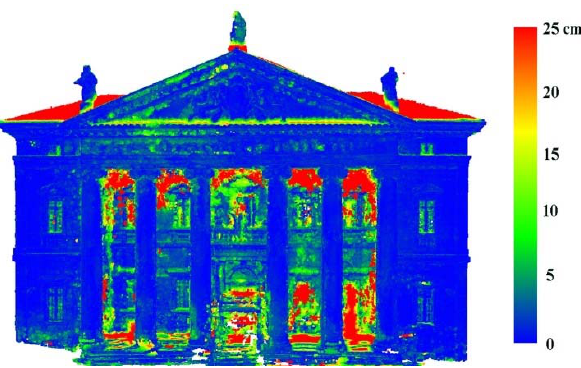
Figure 7. Data comparison between TLS and photogrammetric point clouds